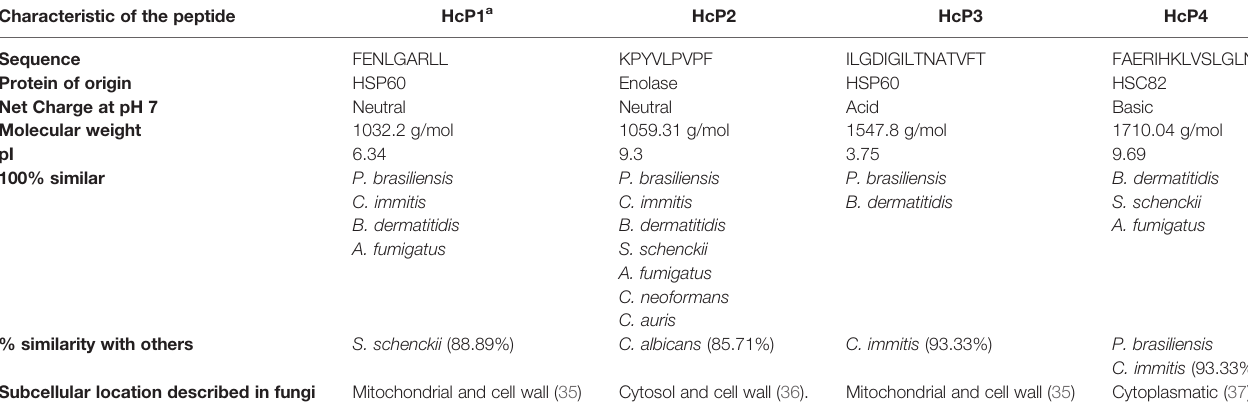
TABLE 3 | Peptides chosen for synthesis and biological testing and their respective characteristics.